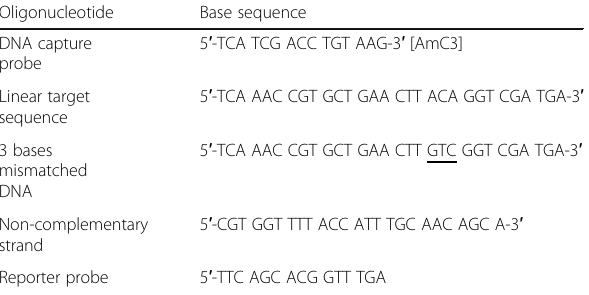
Table 1 The list of DNA sequences used in this study Oligonucleotide Base